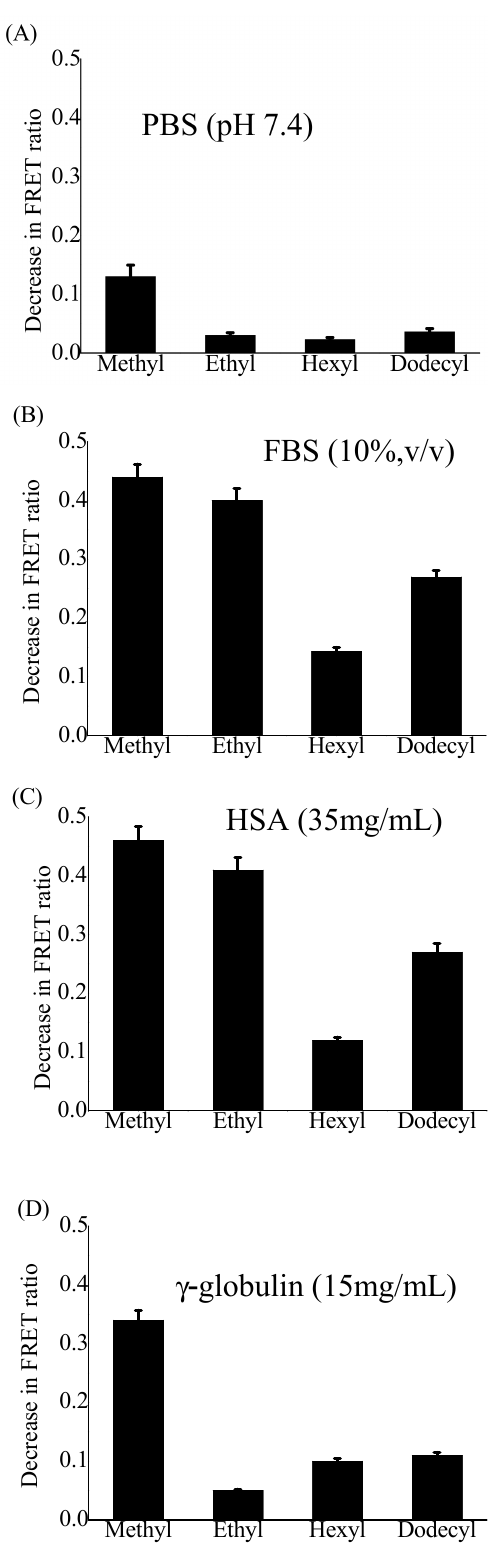
Figure 3. Decrease in the FRET ratio (FRET ratio 0hr -FRET ratio 24h ) of DiO (0.3 wt%) and DiI (0.3 wt%) co-loaded (EtOx) 88 - grad -(ROPhOx) 12 NPs (800 µg/mL) upon incubation with ( A ) PBS (pH 7.4), ( B ) FBS (10%, v / v ) solution in PBS, ( C ) HSA (35 mg/mL), and ( D ) γ -globulin (15 mg/mL) solutions in PBS for 24 h. R = Methyl, ethyl, hexyl, or dodecyl. (Error bars represent standard deviations from the average. n = 3 independent measurements.).